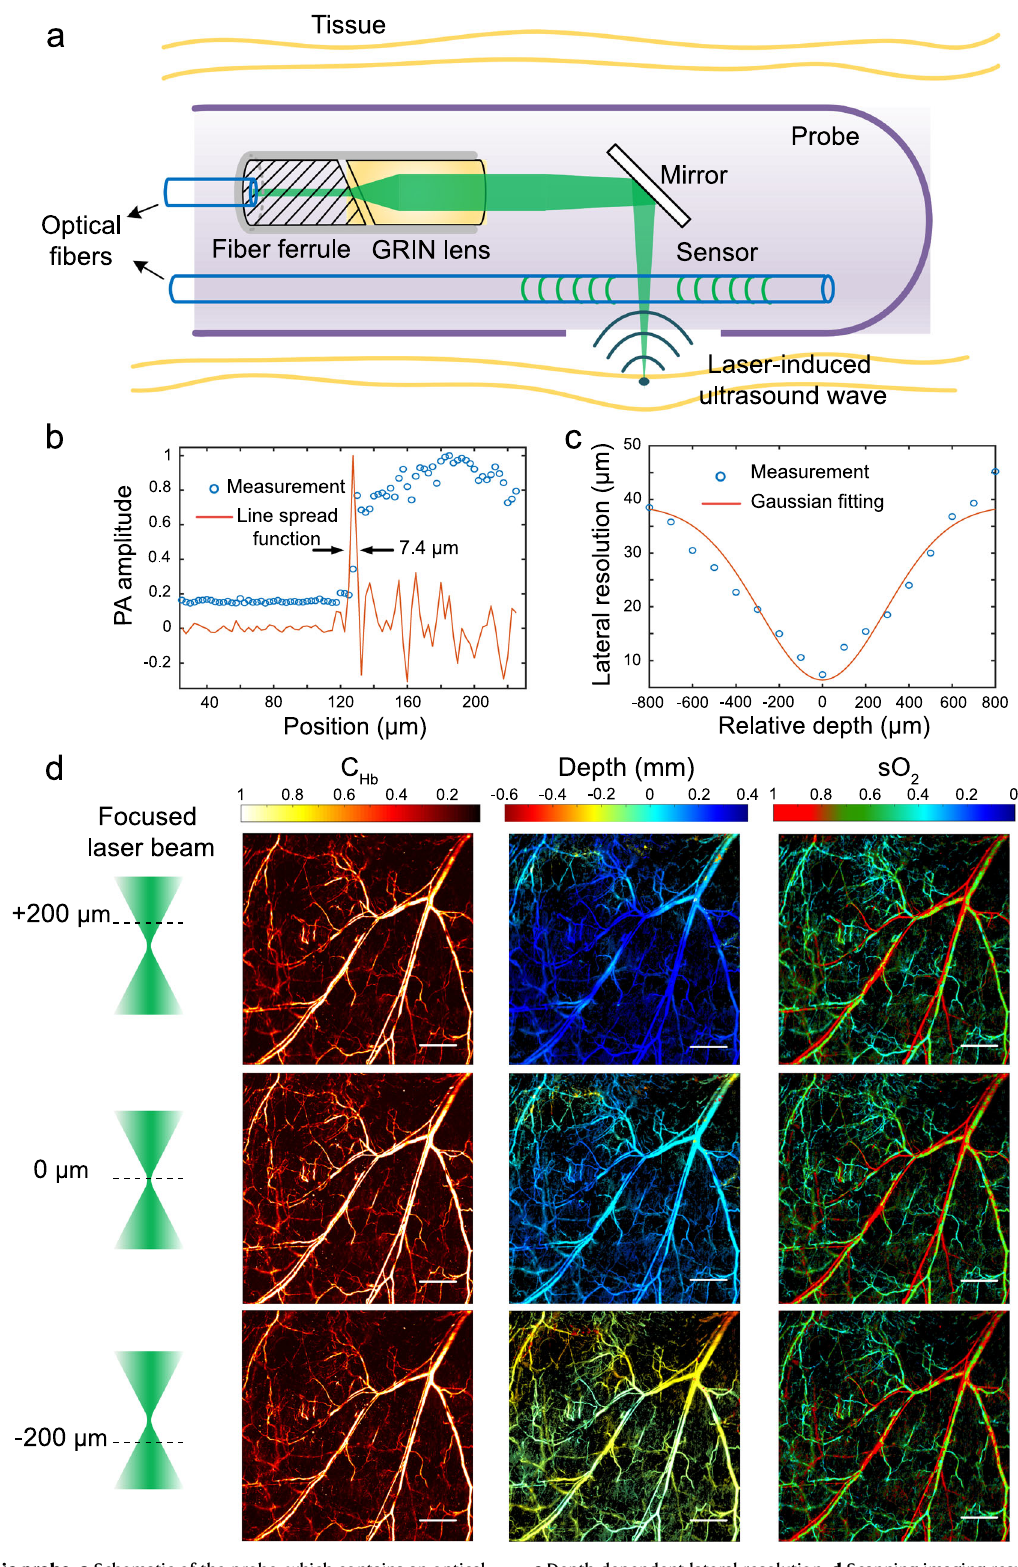
Fig. 2 | Endoscopic probe. a Schematic of the probe, which contains an optical guidance fi bercappedwithaGraded-index(GRIN)lensforexcitationlightdelivery and focusing and a parallel sensor laser for ultrasound detection. b Scanning imaging result of a sharp blade at its edge. Selected B-scan image, and extracted line spread function. The estimated lateral resolution is 7.4 μ m at the laser spot.